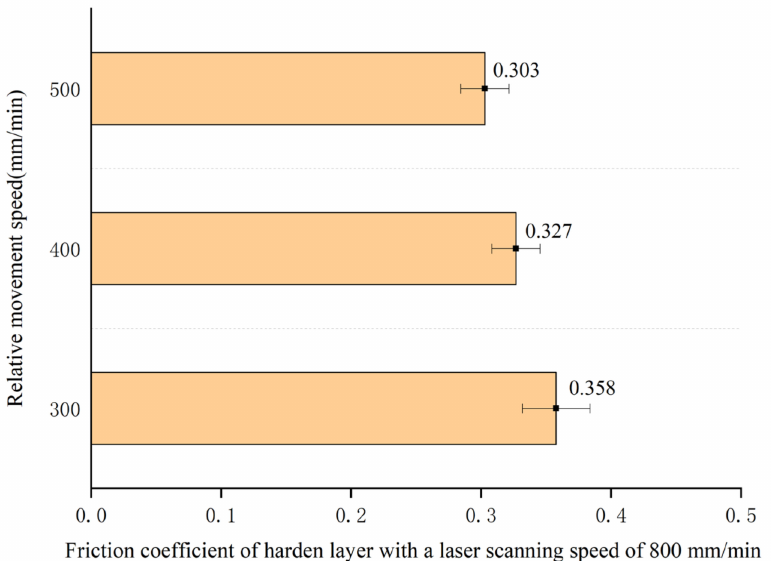
Figure 20. Friction coefficient of hardened layer with a laser scanning speed of 800 mm/min at different movement